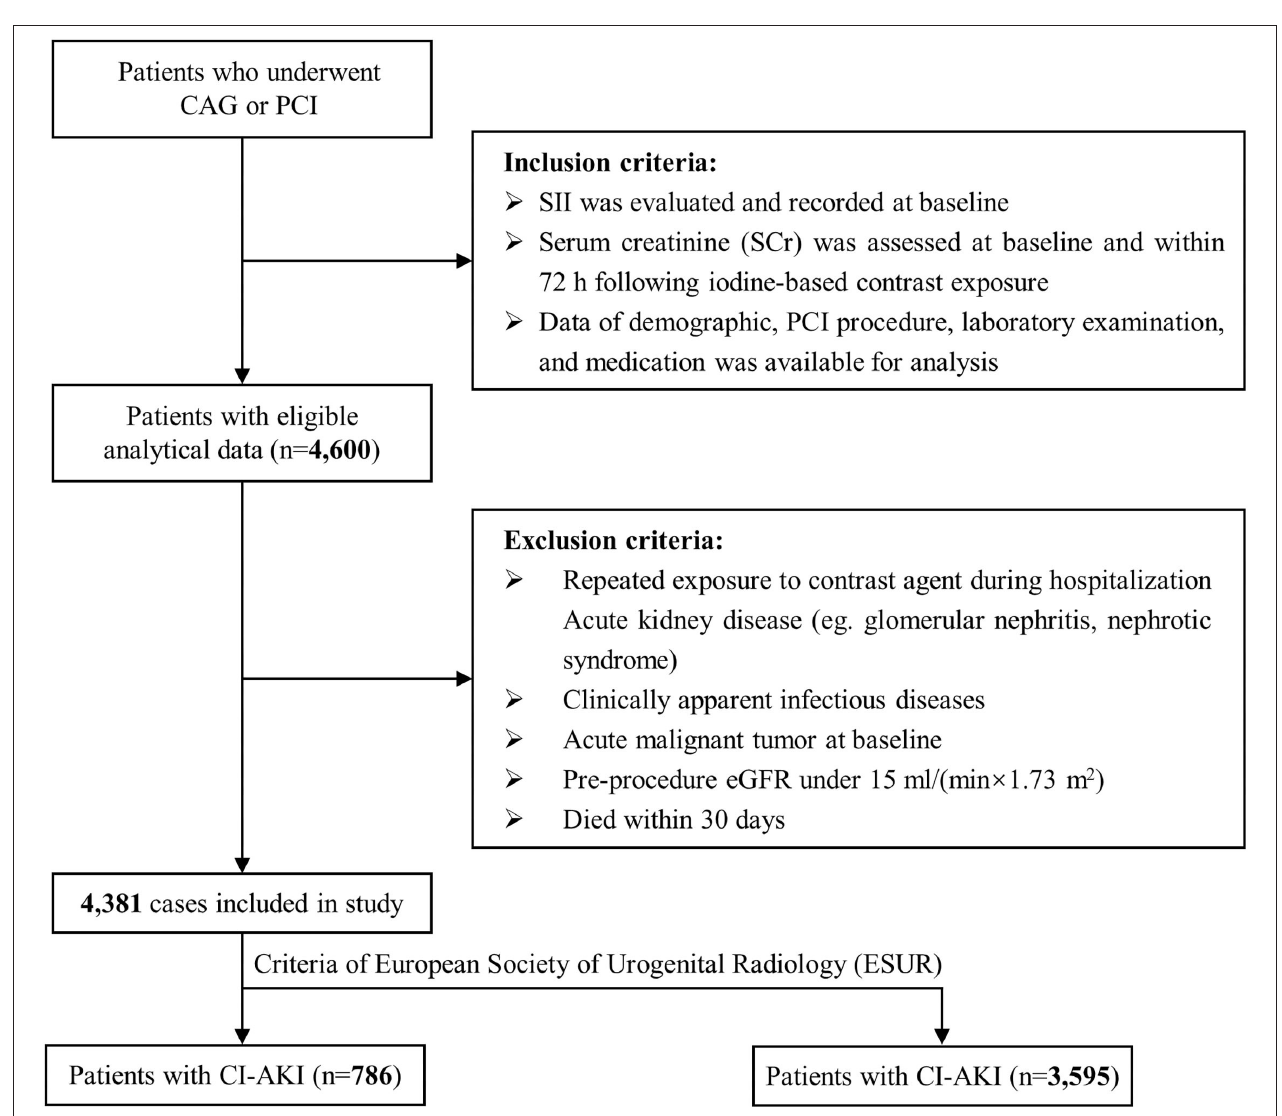
FIGURE 1 | Flowchart of inclusion and exclusion of study population. PCI indicates percutaneous coronary intervention; eGFR, estimated glomerular filtration